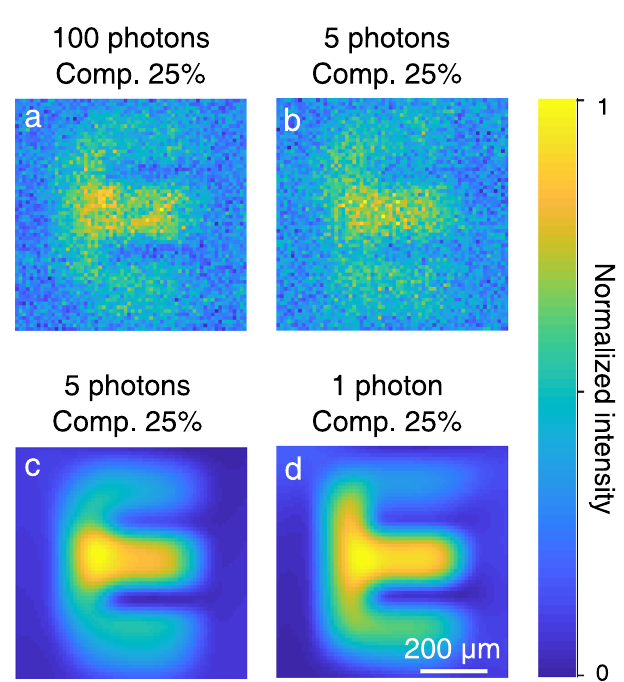
Fig. 5 | MIR single-photon compressive imaging. a , b Reconstructed images under the sub-Nyquist sampling with a compression ratio of 25% for MIR illumi- nation intensity of 100 and 5 photons/pulse, respectively. c , d Reconstructed images by using a numerical Gaussian denoiser based on deep-learning convolu- tionalneuralnetworks,whichpermitstoobtainhigh-contrastimagesforalow-light fl ux down to 1 photon/pulse. Note that random patterns are used here to perform the compressive sensing algorithm, and each image contains 64×64